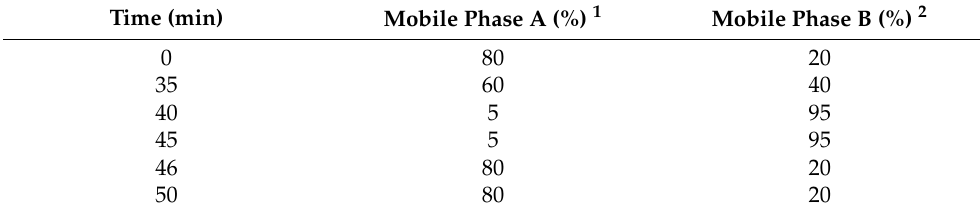
Table 3. Gradient of the mobile